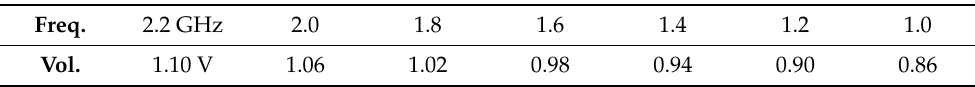
Table 2. P-states in Intel(R) Xeon(R) Silver 4114.